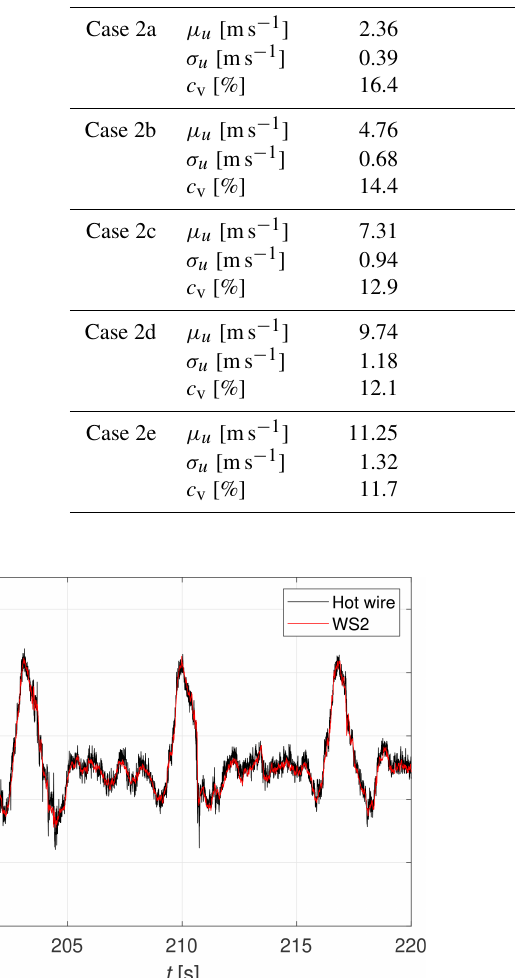
Table 4. Statistics of the hot-wire and WindScanner time series of the u component of the wind speed. Variable